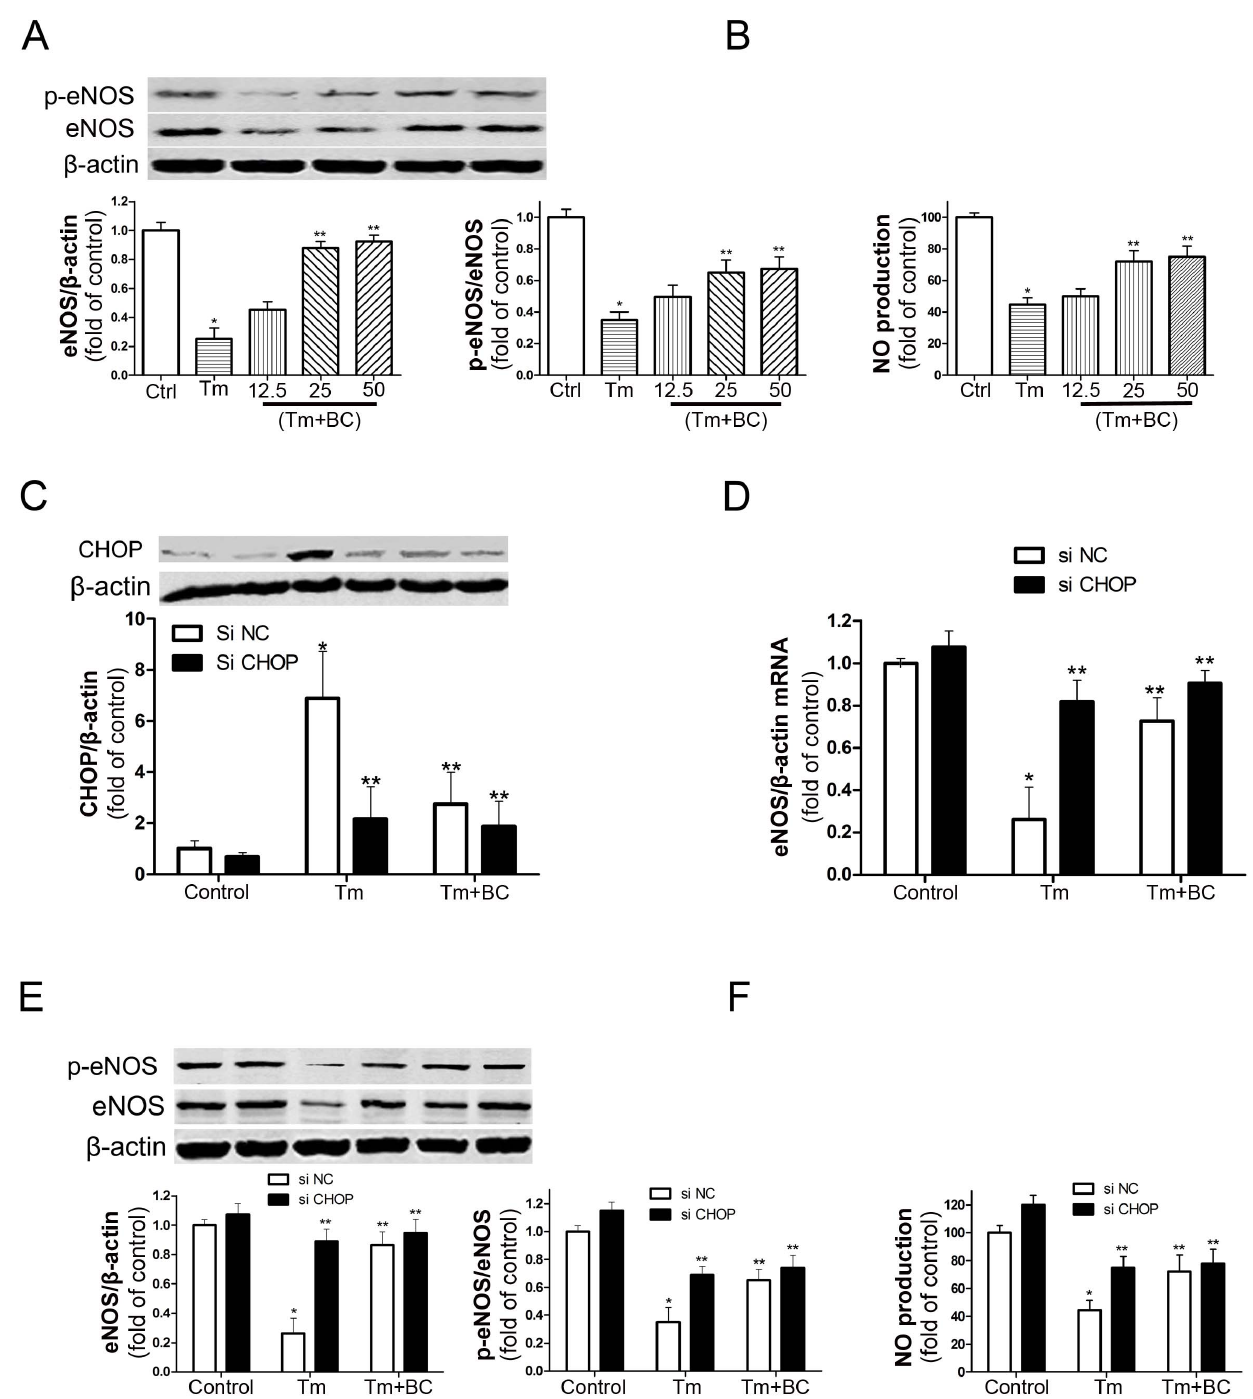
Figure 5. CHOP dependent induction of endothelial nitric oxide synthase (eNOS) in BC treated cardiomyocytes. (A) Cardiomyocytes were treated with Tm (100 ng/ml) in the presence or absence of baicalin (BC) for 24 h at indicated concentrations (12.5, 25, 50 m M). The expressions of eNOS and phospho eNOS at protein levels were examined by western blot. (B) BC treatment increased NO production in cultured cardiomyocytes. Cardiomyocytes were treated with Tm (100 ng/ml) in the presence or absence of baicalin (BC) for 24 h and incubated with 10 m M of DAF-FM and fluorescence intensity was assayed. (C) CHOP knockdown efficiency was tested by western blot. Cells transfected with either control siRNA or siRNA targeting CHOP were further treated with Tm (100 ng/ml) in the presence or absence of baicalin (BC, 25 m M) for 24 h. (D) The expression of eNOS mRNA levels was examined by real-time quantitative PCR. Cells were treated as C. (E) The expressions of eNOS and phospho eNOS protein levels were examined by western blot. Cells were treated as C. (F) NO production was measured by DAF-FM and fluorescence intensity was assayed. Cells were treated as C. A, B: *P , 0.05 vs Ctrl, **P , 0.05 vs Tm, n=5; C, D, E, F: *P , 0.05 vs Control + si NC, **P , 0.05 vs Tm + si NC, n=5.